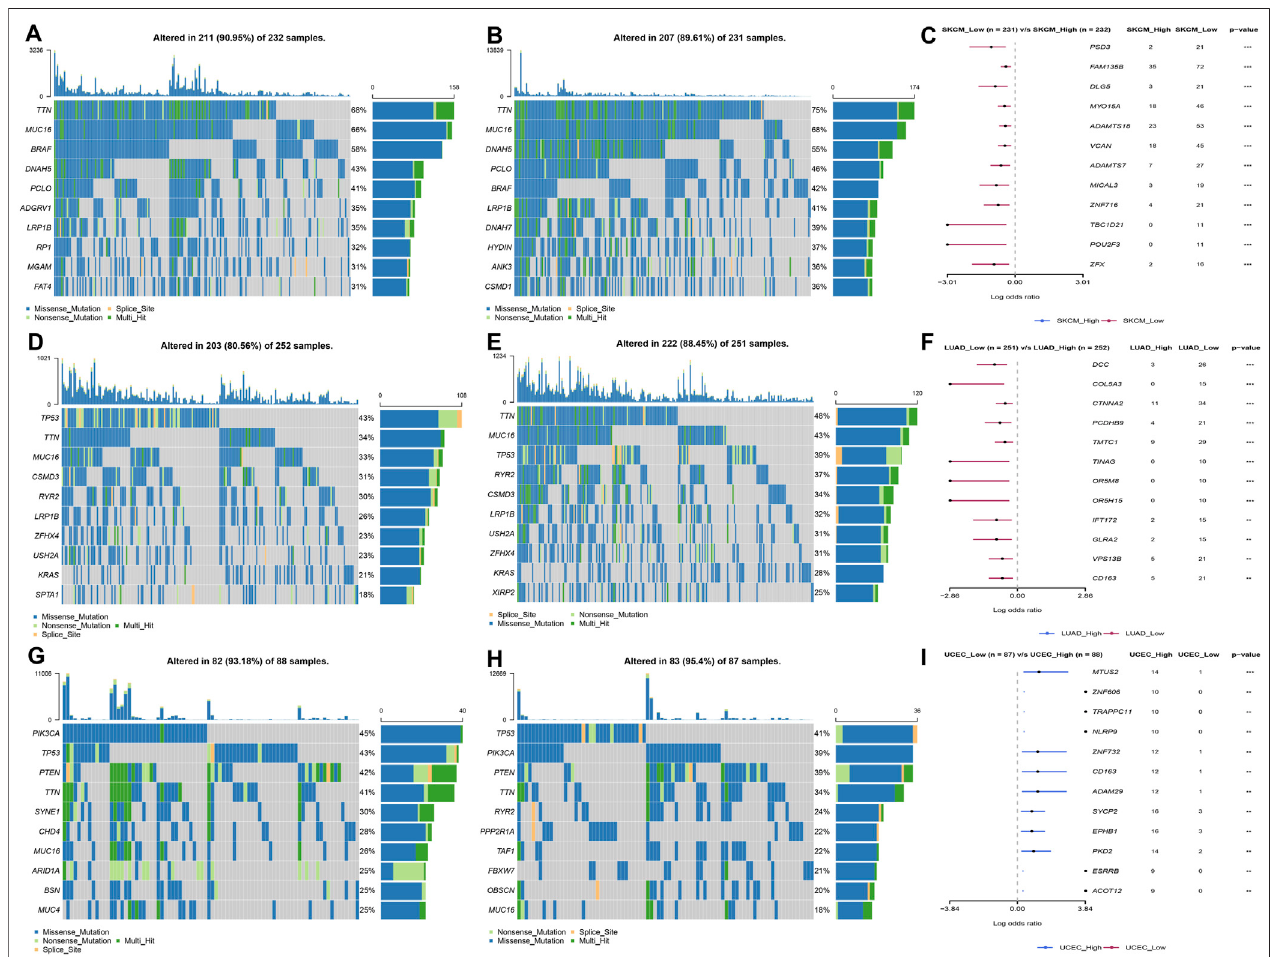
FIGURE 7 | Somatic mutated pro fi le between high- and low-LY96 expression groups. (A – C) Somatic mutated pro fi le in high-LY96 expression group (A) and low- LY96 expression group (B) and differently mutated genes between high- and low-LY96 expression groups in (C) skin cutaneous melanoma (SKCM). (D – F) Somatic mutatedpro fi leinhigh-LY96expressiongroup (D) andlow-LY96expressiongroup (E) anddifferentlymutatedgenesbetweenhigh-andlow-LY96expressiongroupsin (F) lung adenocarcinoma (LUAD). (G – I) Somatic mutated pro fi le in high-LY96 expression group (G) and low-LY96 expression group (H) and differently mutated genes between high- and low-LY96 expression groups in (I) uterine corpus endometrial carcinoma (UCEC).